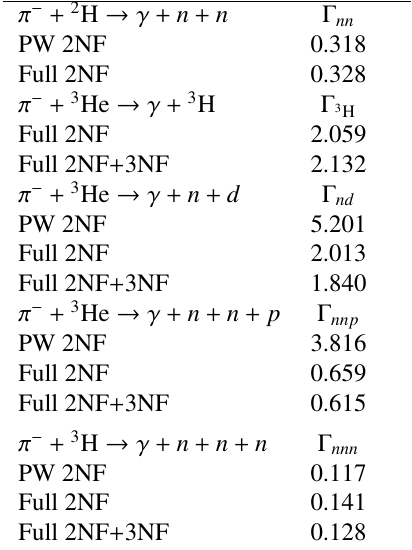
Table 1. Total rates Γ in 10 15 1 / s for radiative pion capture in 2 H, 3 He and 3 H obtained with the AV18 [27] nucleon-nucleon potential and the transition operator given in Eq. (2). Results calculated using the plane wave impulse approximation (PW 2NF), with a consistent treatment of the initial and final nuclear states based on two-nucleon forces only (Full 2NF) and, additionally, including the Urbana IX [28] three-nucleon force (Full 2NF + 3NF) are